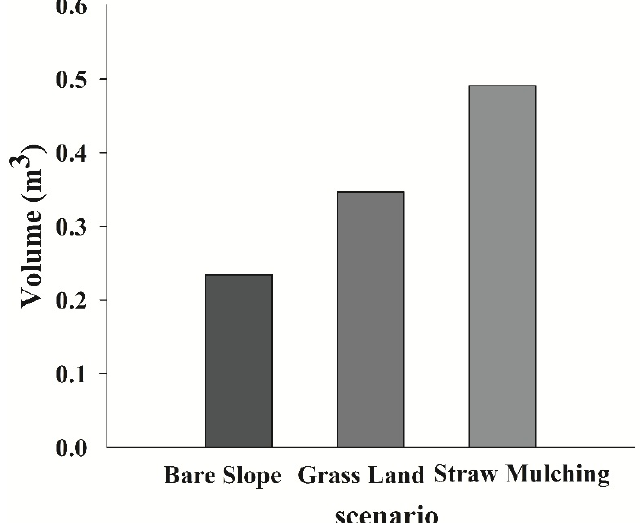
Figure 10. Comparison of accumulated volume of the groundwater among three